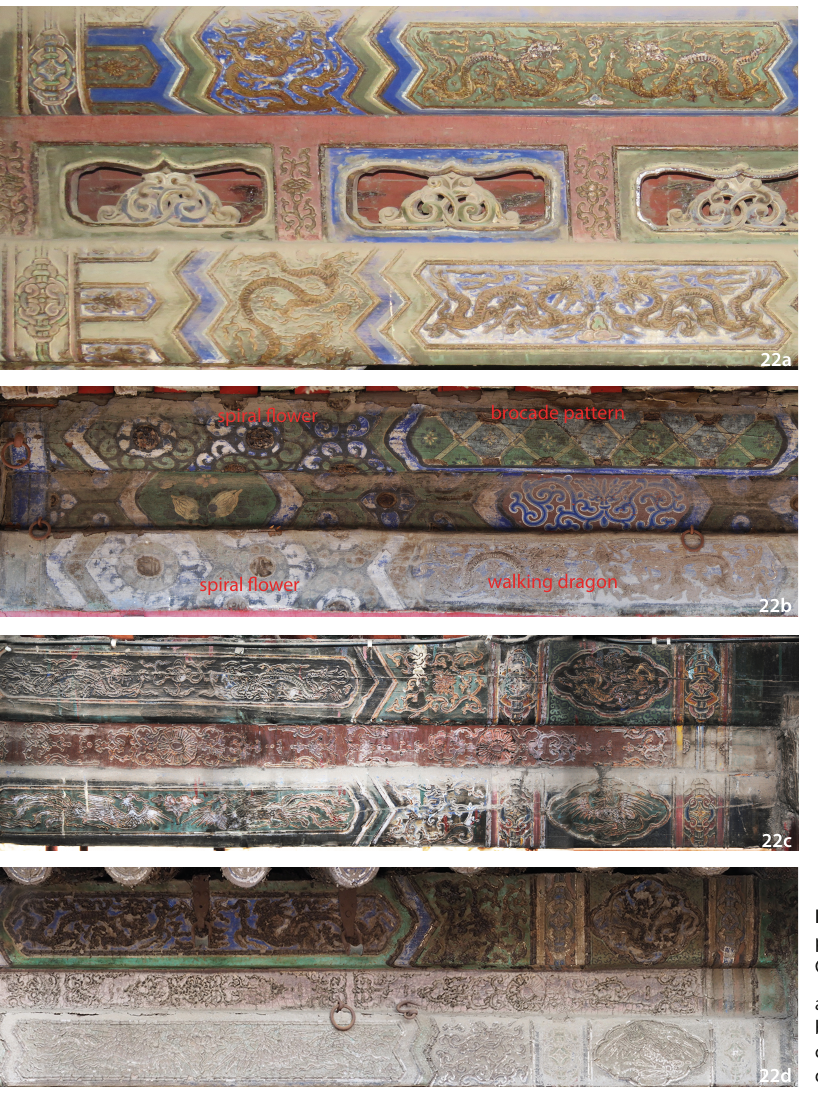
Figure 22 Types of decorative polychrome painting in the Hall of Mental Cultivation Complex (Source: Hong